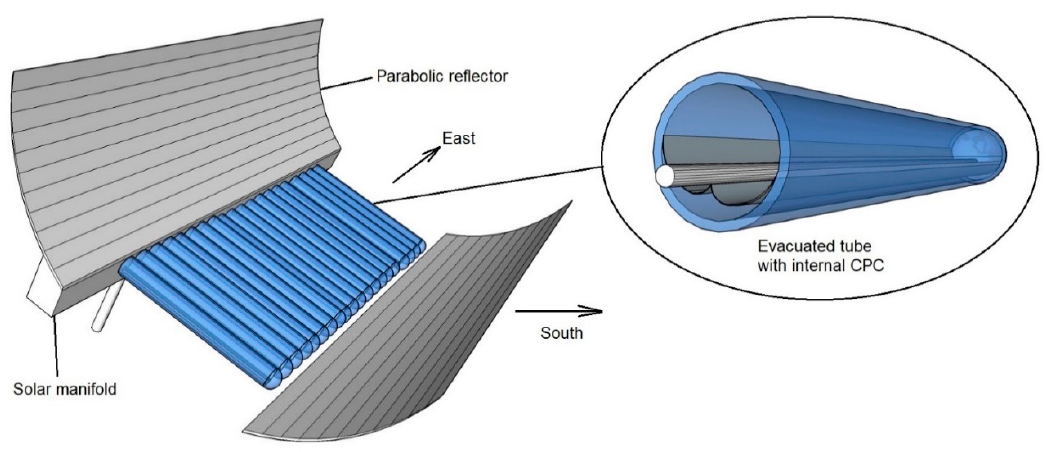
Figure 27. Schematic diagram of two-stage concentrating CPC.